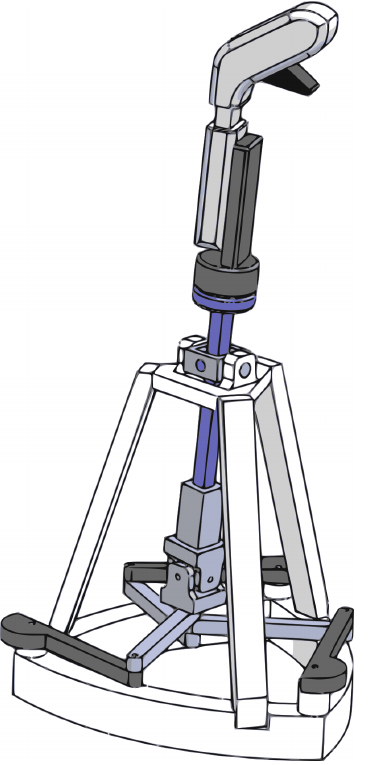
Figure 5. CAD model of the new hybrid-haptic device for laparo- scopic surgery.